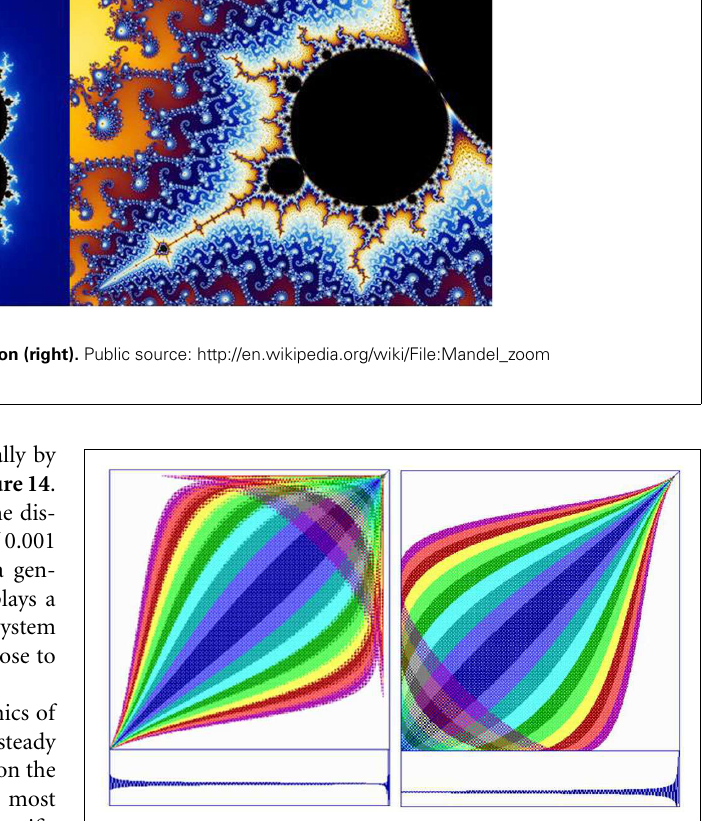
FIGURE 14 | Recurrence plot of z real (left) and z imag (right) scaled from point 1 to point 629 or the 633-point time series (lower traces). The system diverges toward infinity at the end of the each series, but the dynamics of the real and imaginary components are rather